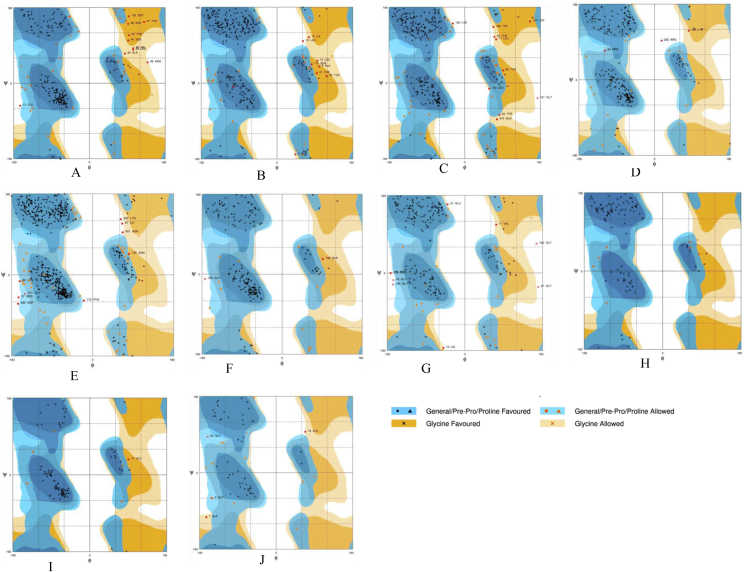
Surface accessibility of linkers in the final multi-epitope constructs. A. Construct 1; B. Construct 2; C. Construct 3; D. Construct 4; E. Construct 5; F. Construct 6; G. Construct 7; H. Construct 8; I. Construct 9; and J. Construct 10. Blue color represents AAY linker, cyan represents KK linker and GGGGS is represented by red color.